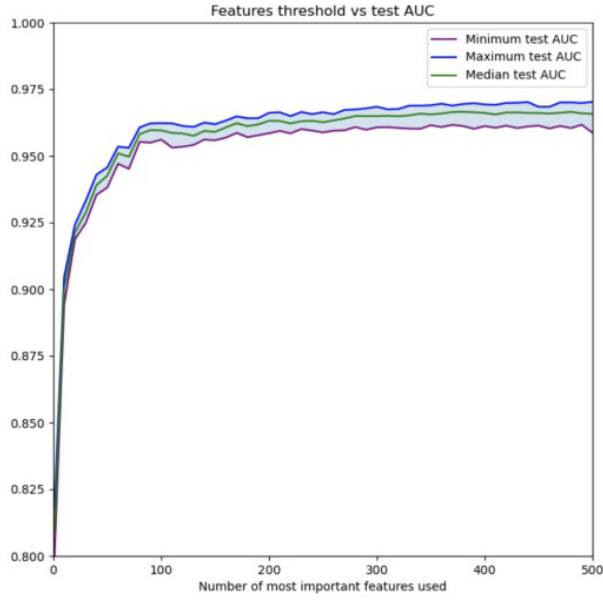
Figure 4. AUC of the Boosting method using the most important features.